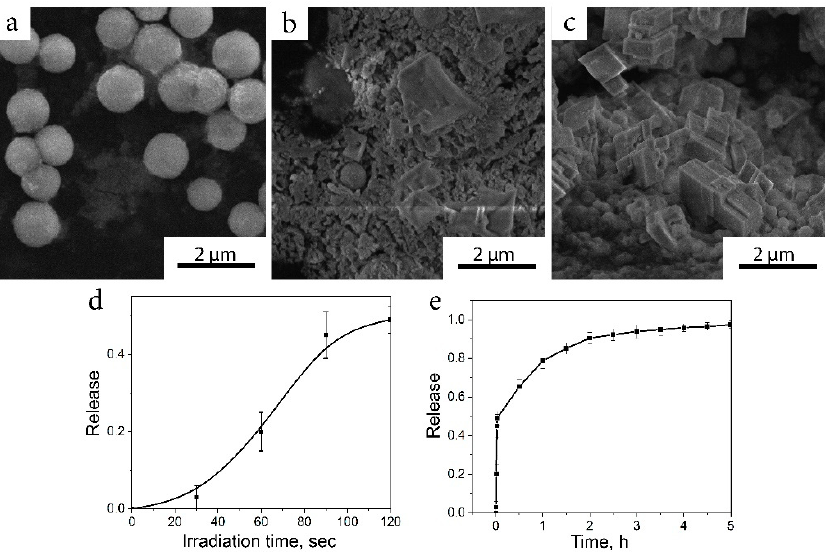
Figure 4. ( a – c ) Under the influence of the RF field, vaterite underwent blast-like destruction with a subsequent crystallization into the calcite phase; ( d ) under RF irradiation, burst release of ciprofloxacin occurred with ( e ) a subsequent slow release of the drug.